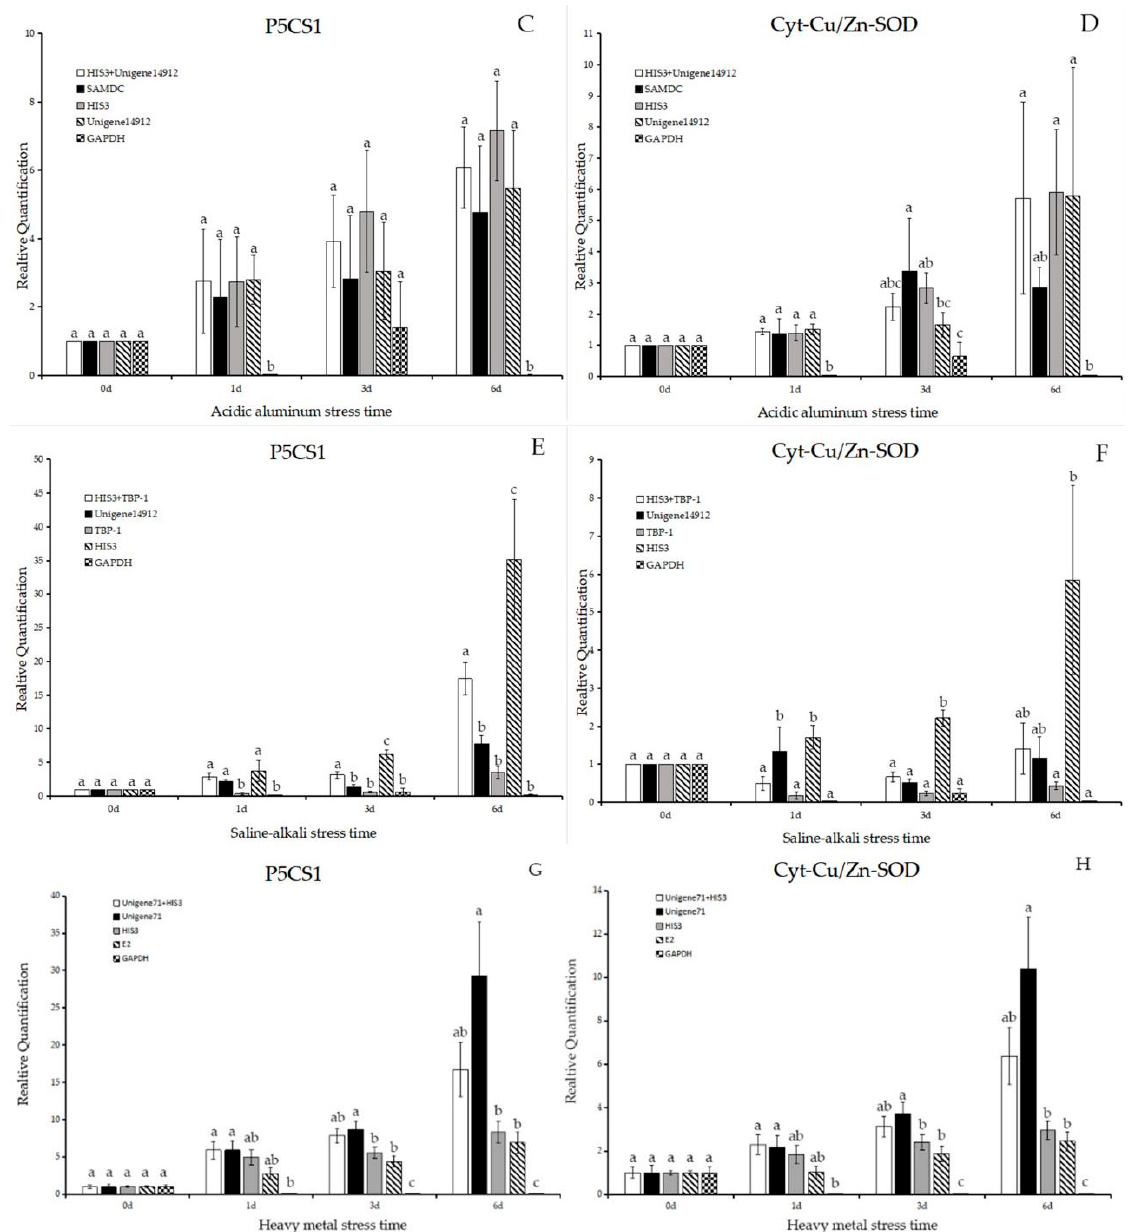
Figure 6. Expression levels of P5CS1 and Cyt-Cu/Zn SOD in annual ryegrass leaves under different stresses(drought stress, saline-alkali stress, acidic aluminum stress, heavy metal stress) at different times (days 0, 1, 3 and 6). ( A – H ) represent expression levels of P5CS1 and Cyt-Cu/Zn SOD. Bars indicate standard errors and different letters above the bars represent significant differences ( p < 0.05).